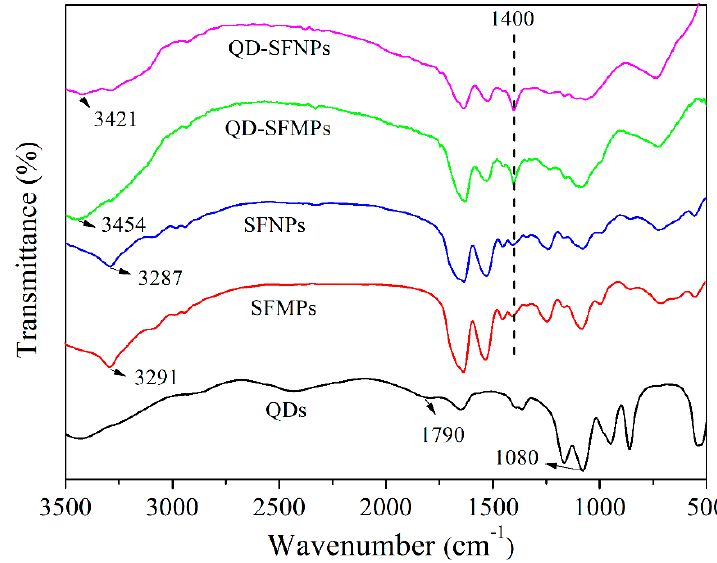
Figure 4. FTIR spectra of silk fibroin particles before and after QD labeling.